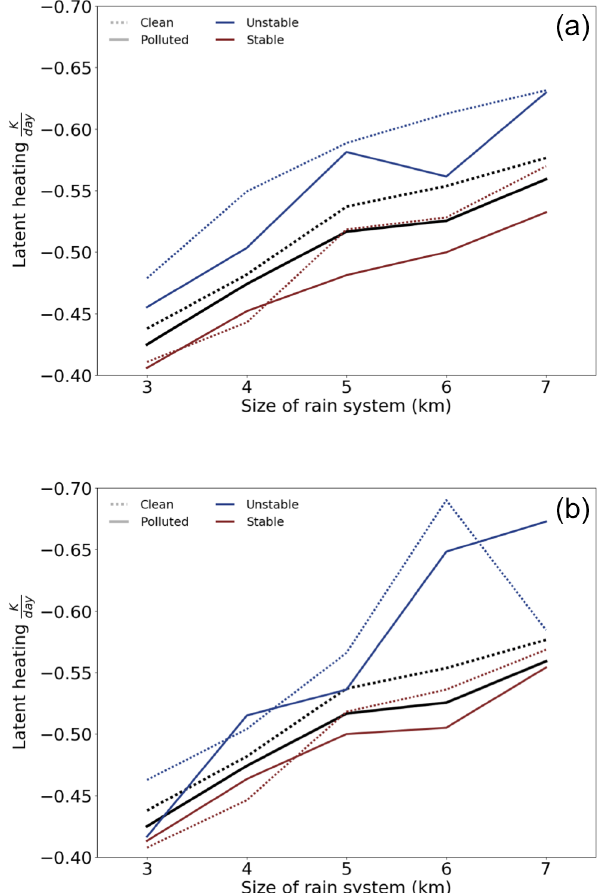
Figure 5. The mean rate of latent heating due to evaporation below the cloud as a function of rain system size for all (a) and dry (b) warm clouds with an extent of 15km. Black is for all stabilities, blue is for unstable environments, and red is for stable environments; dashed represents pristine and solid represents polluted surround-